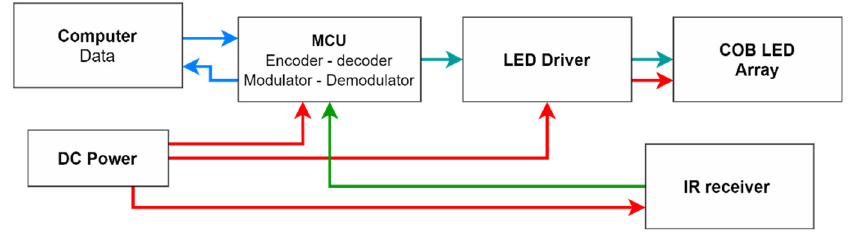
Figure 4. Structure of the transceiver-illumination system.